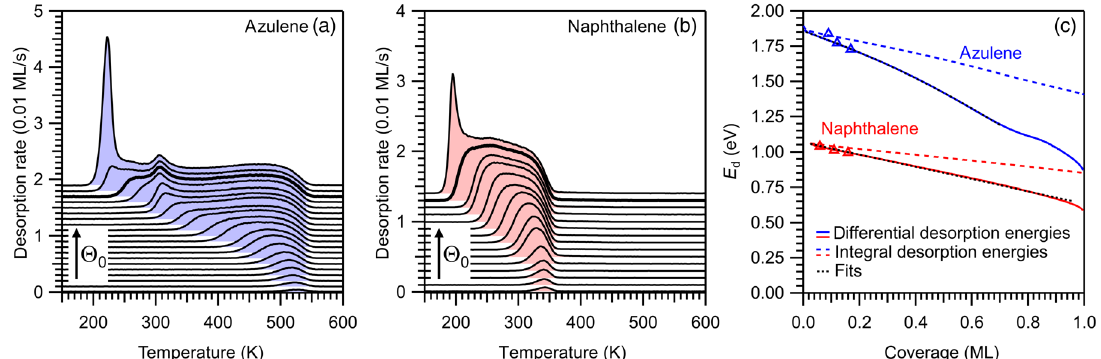
FIG. 3. TPD traces of (a) azulene and (b) naphthalene on Cu(111), with a heating rate 1 . 0 K = s. Curves with different initial coverage Θ 0 are shifted along thevertical axis for clarity, but we start with a zero desorption rate in each case. The monolayer coverages are marked by bold lines. The other initial coverages are listed in Tables S II in the Supplemental Material [44]. (c) Desorption activation energies as a function of coverage for azulene (blue) and naphthalene(red). Solid lines: Differential desorption energies. Dashed lines: Integral energies forcomparison with DFT calculations. Black dotted lines: Fits of the differential desorption energies with the equations mentioned in the text. Triangles: Energies from HRV analysis. Note that HRV is only possible at low coverages, where the peaks have a regular first-order